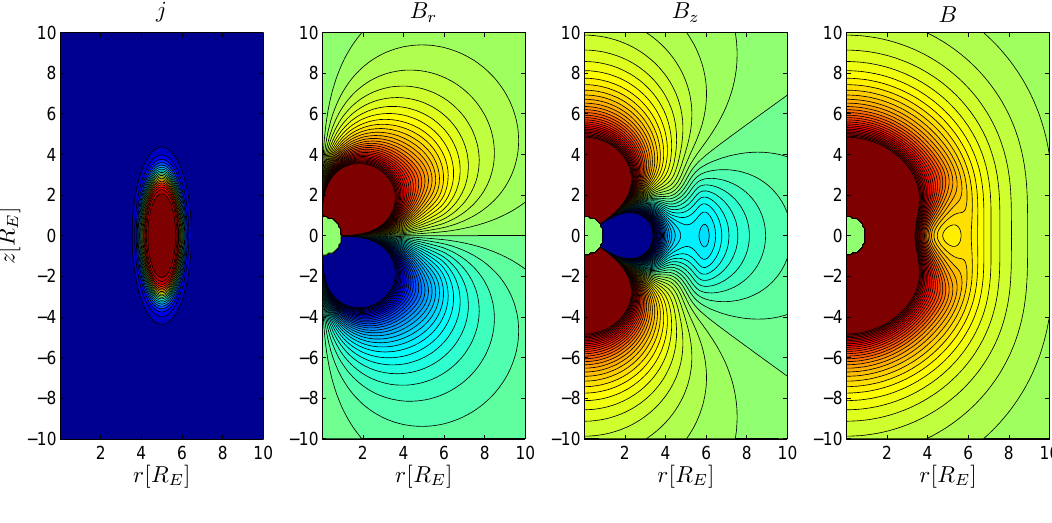
Fig. 11. Axisymmetric ring current distribution j , with a peak current of 20 nA · m − 2 , and the magnetic field it induces, superposed onto a (non-tilted) terrestrial dipole field. From left to right: current density j , radial field B r , axial field B z , and field strength B . Magnetic field contours are drawn at 20 nT intervals; no contours are drawn close to Earth as the magnetic field rises sharply there.